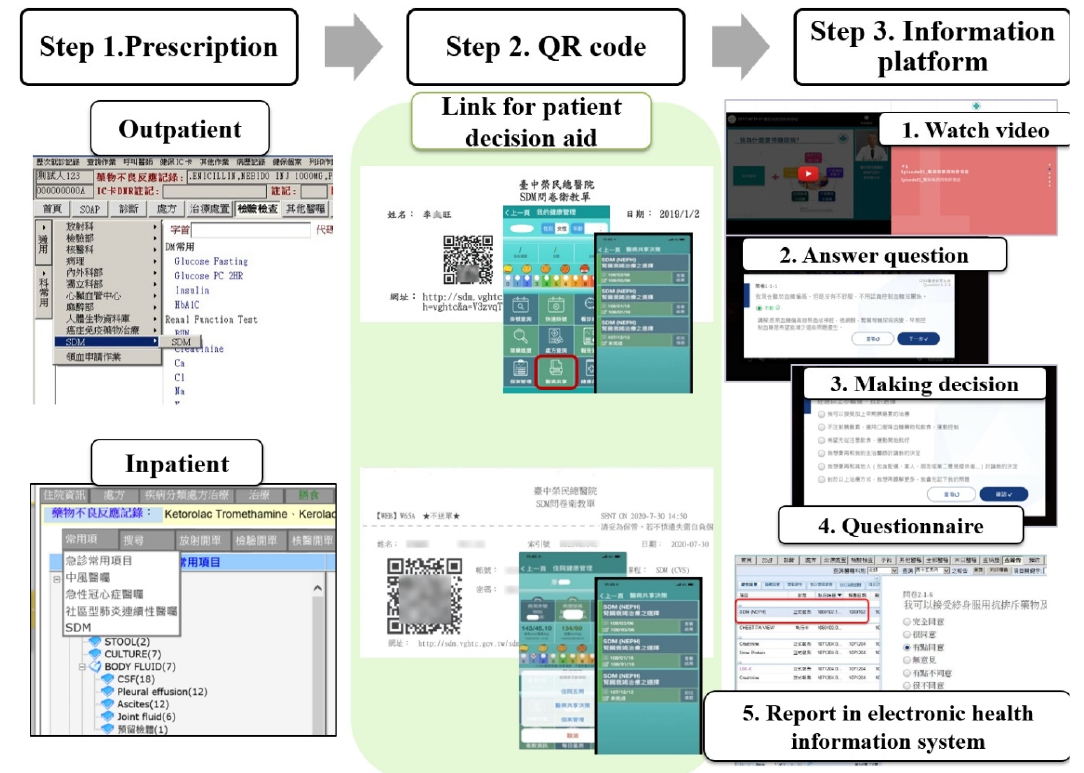
Figure 4. Three steps for shared decision making of renal biopsy.